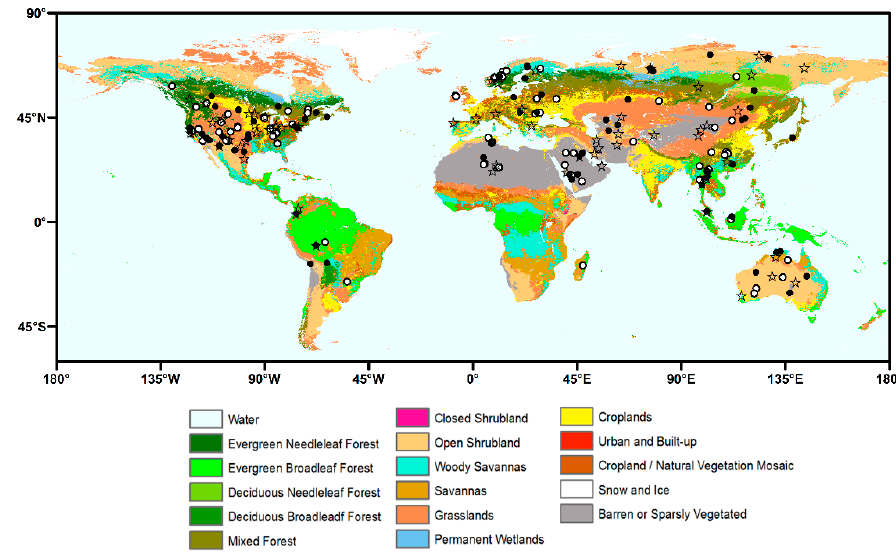
Figure 1. Locations of three sets of 67 Integrated Surface Global Hourly (ISH) stations used for algorithm training (white solid circles), and validation of Vapor Pressure Deficit (VPD) retrievals over the Advanced Microwave Scanning Radiometer for EOS (AMSR-E; 2010; black solid circles) and Advanced Microwave Scanning Radiometer 2 (AMSR2) (2013; star symbols) portions of record. Station locations are presented with the Moderate Resolution Imaging Spectroradiometer (MODIS) International Geosphere-Biosphere Programme (IGBP) land cover